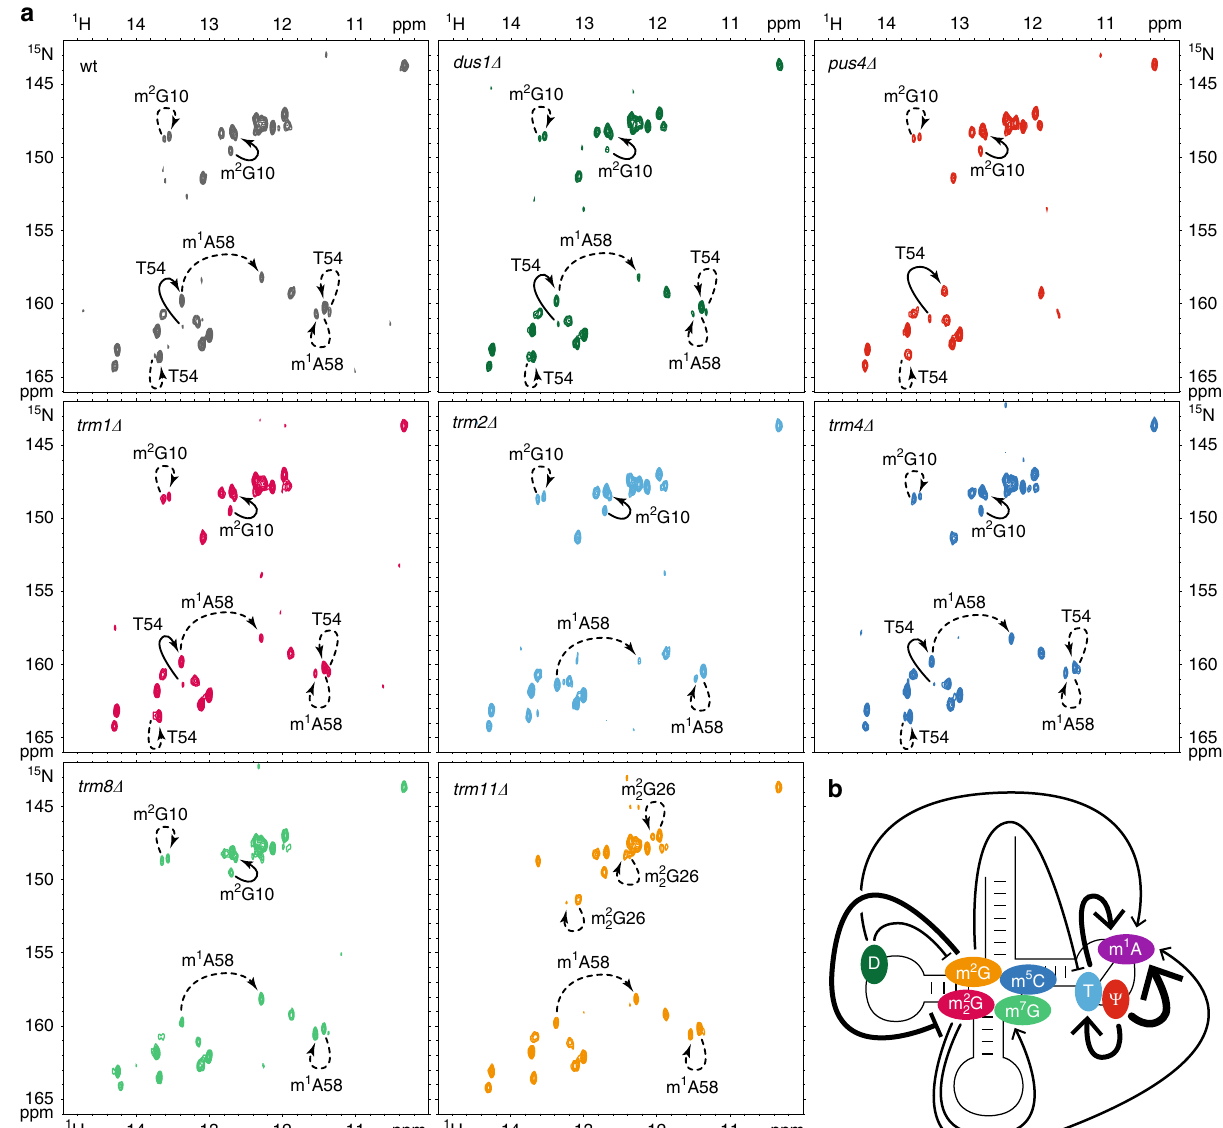
Fig. 5 Complex modi fi cation circuits in yeast tRNA Phe . a Imino ( 1 H, 15 N) correlation spectra of a 15 N-labeled tRNA Phe measured after 16 h of incubation at 30 °C in yeast extracts prepared from wild-type cells (top left spectrum) and in yeast extracts depleted of one modi fi cation enzyme at a time, namely dus1 Δ , pus4 Δ , trm1 Δ , trm2 Δ , trm4 Δ , trm8 Δ , and trm11 Δ . Each NMR spectrum measurement spreads over a 2 h time period ( t = 16 – 18 h). Complete series of time-resolved NMR monitoring of tRNA Phe maturation in the different depleted yeast extracts are given in Supplementary Figs. 2 – 8. Modi fi cations occurring at this speci fi c step in each extract are reported with continuous line arrows for direct effects, or dashed arrows for indirect effects. Each strain is associated with a de fi ned color also used in panel b . b Schematic view of the modi fi cation circuits revealed by the NMR monitoring of tRNA Phe maturation in the different yeast extracts of panel a . Each modi fi cation is displayed on the cloverleaf structure with its associated color also used in Figs. 4 and 6. Arrows indicate stimulatory effects and blunted lines inhibitory effects. Thick and thin lines indicate strong and slight effects,